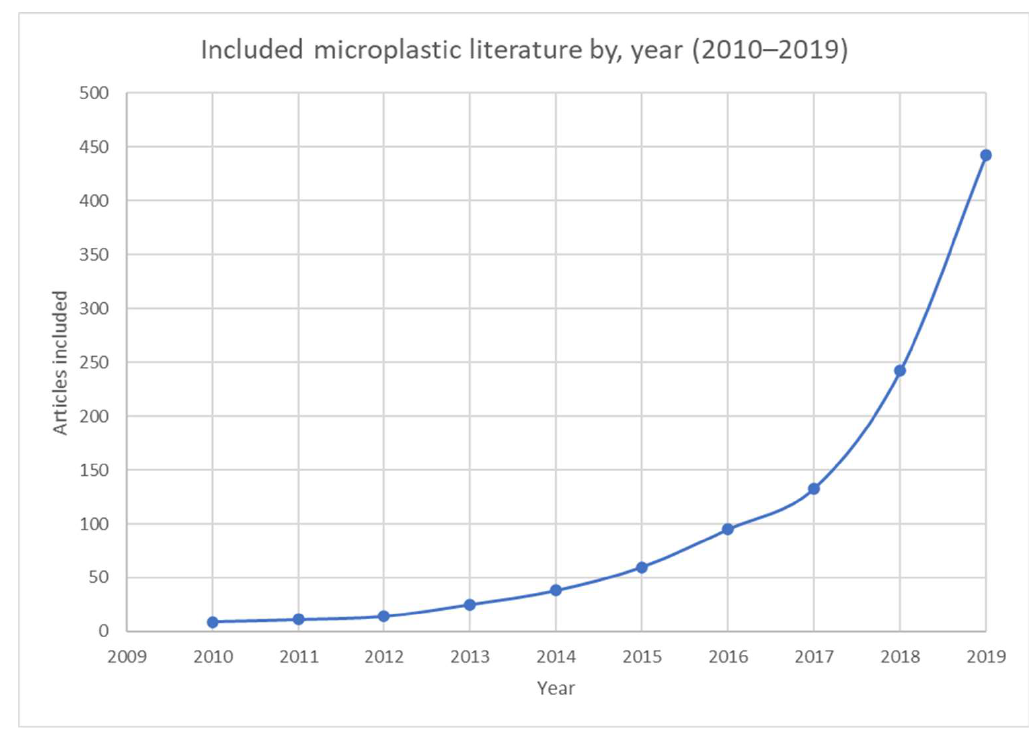
Figure 2. Publications focusing on microplastics by date of publication.